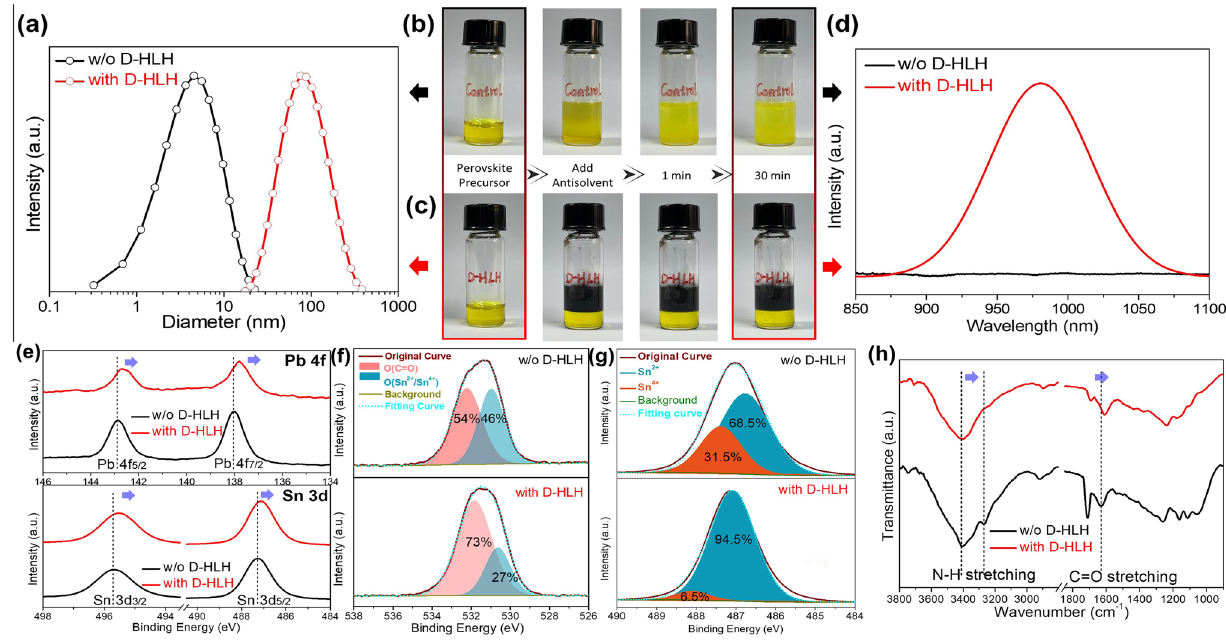
Fig. 2 a DLS measurements of the colloidal sizes of the perovskite precursor solutions prepared with and without D‑HLH. Photographs of perovskite precursor solutions prepared b without and c with D‑HLH, taken before and after adding the antisolvent. d PL spectra of precursor solutions prepared with and without D‑HLH. XPS spectra of perovskites prepared with and without D‑HLH: e Pb 4 f and Sn 3 d , f O 1 s , and g